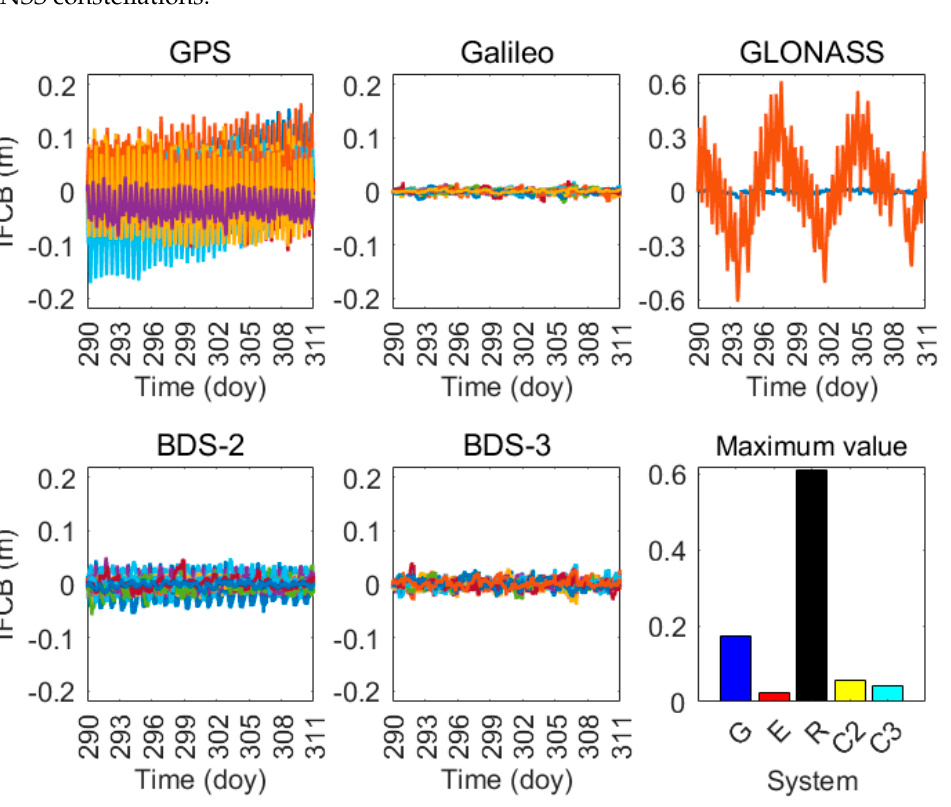
Figure 5. The multi-GNSS IFCB series and maximum values from DOY 290, 2021 to DOY 310, 2021. A different color line represents a different satellite.